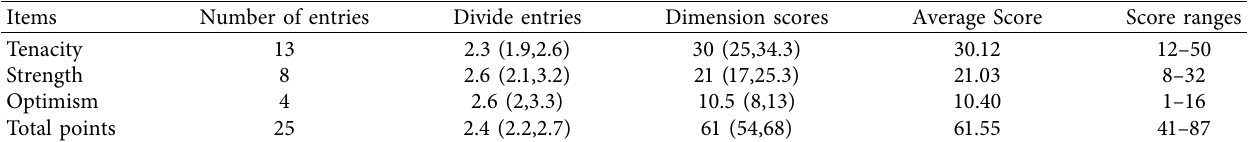
Table 4: Guardian’s CD-RISC rating.